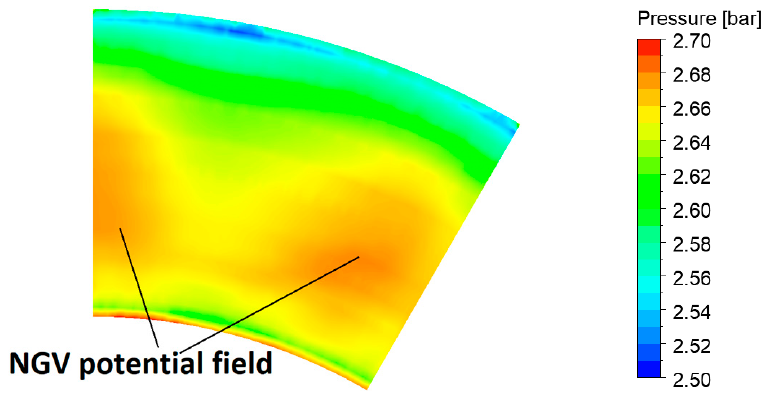
Figure 9. Non-uniform pressure distribution at the combustor–turbine interface.